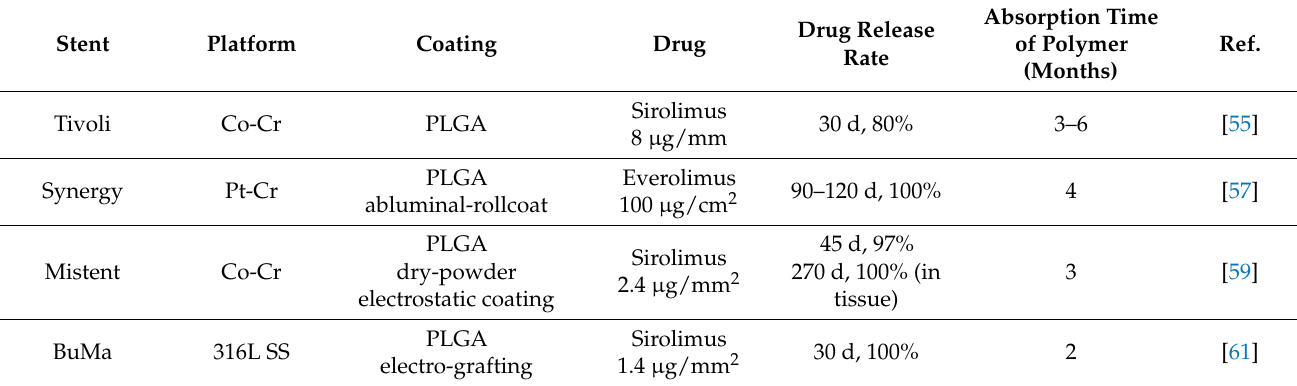
Table 4. DESs with poly(lactic- co -glycolic acid)